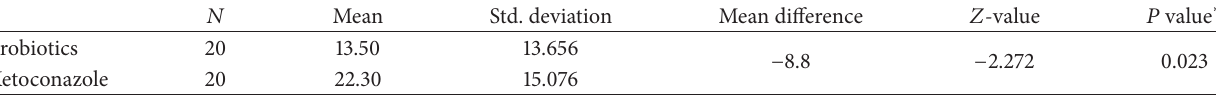
Table 4: Comparison of zone of inhibition between probiotics and